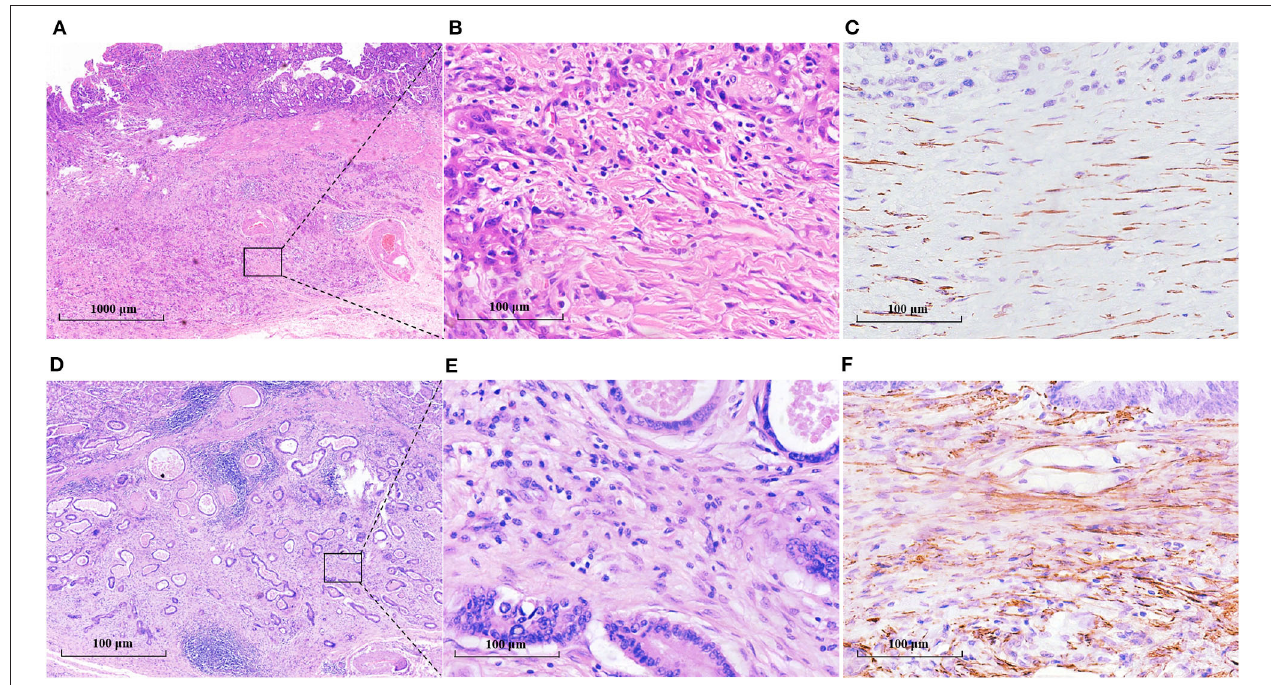
FIGURE 5 | The morphological characteristics and α -SMA expression of mature and immature CAFs in tumor tissues. (A–C) Mature CAFs: the cancer invaded the deep submucosa (SM2), and mature CAFs mainly constituted the stroma (A) . (B) was the amplification of the black frame in A and showed thin spindle fibroblasts with fine elongated collagen fibers. C showed the mature CAFs with weak positive α -SMA staining. (D–F) Immature CAFs: the cancer invaded the deep submucosa (SM2), and immature CAFs mainly constituted the stroma (D) . (E) was the amplification of the black frame in (D) and showed plump spindle fibroblast cells without obvious collagen fibers. (F) showed the immature CAFs with a highly positive expression of α